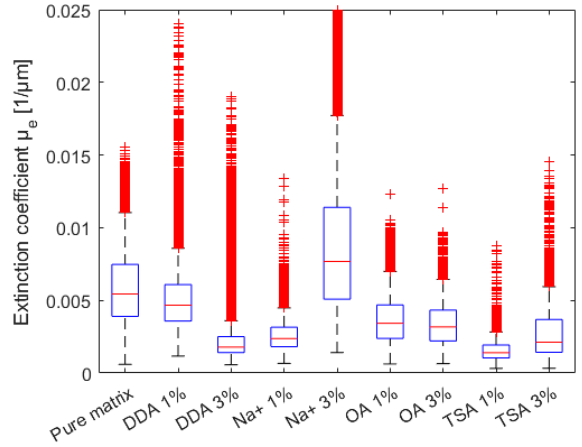
Figure 12. Distribution of the normalized extinction coefficient.